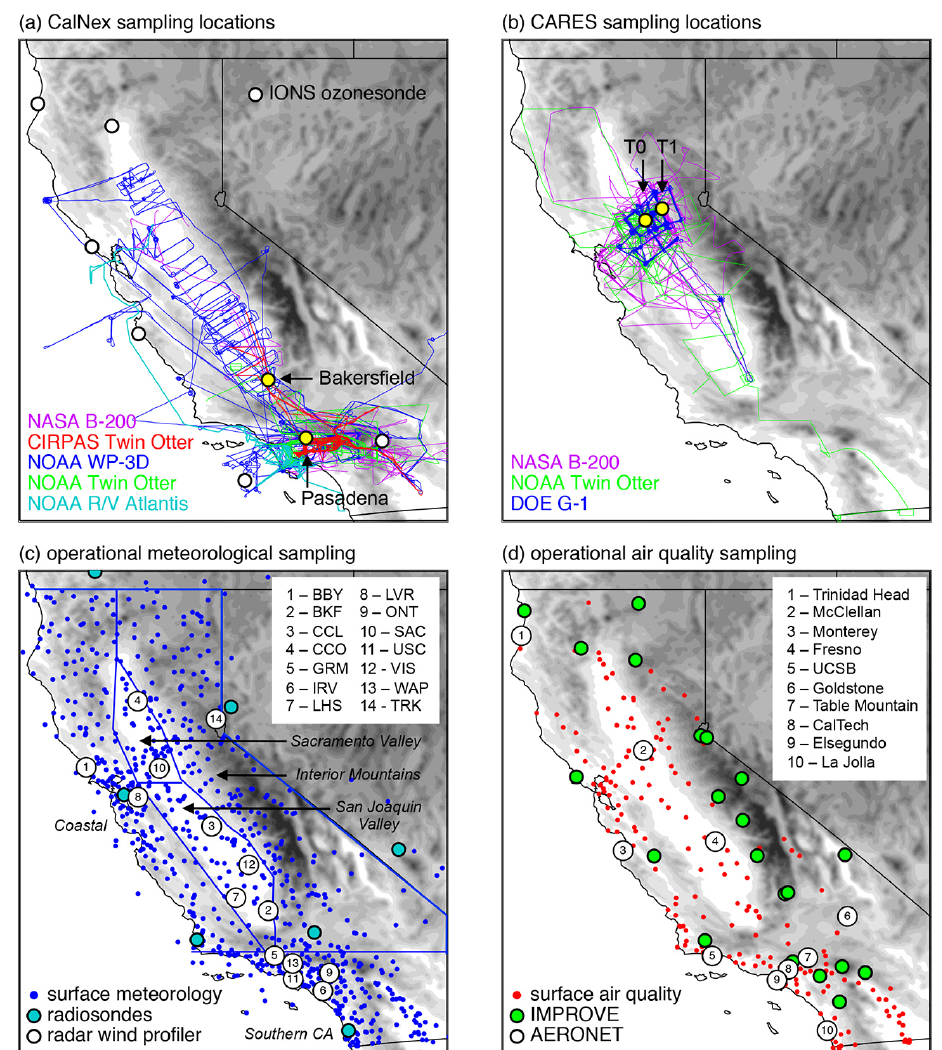
Figure 1. Geographic distributions of fixed and mobile sampling during the (a) CalNex and (b) CARES campaigns along with operational (c) meteorological and (d) air quality sampling sites. Yellow circle in (a) and (b) denote measurement supersites while blue lines in (c) denote geographic regions to compute statistics. Gray shading denotes model topography using 1x = 4km. The modeling domain extends ∼ 150km west of the western boundary shown above. BBY = Bodega Bay, BKF = Bakersfield, CCL = Chowchilla, CCO = Chico, GRM = Gorman, IRV = Irvine, LHS = Lost Hills, LVR = Livermore, ONT = Ontario, SAC = Sacramento, USC = University of Southern California, VIS = Visalia, WAP = Whiteman Airport Pacomia, TRK =